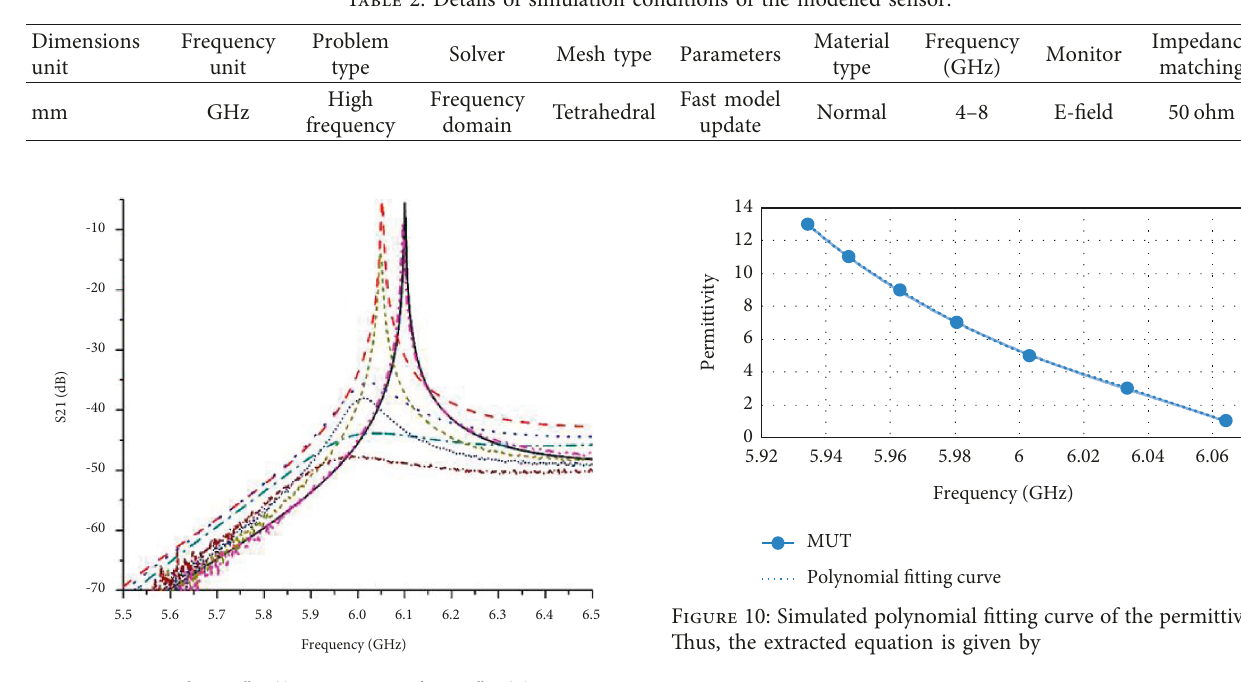
Table 2: Details of simulation conditions of the modelled sensor.